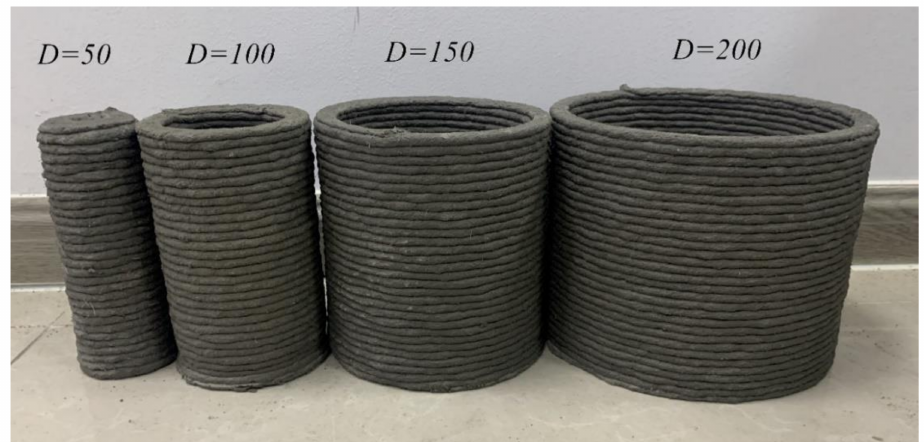
Figure 13. The four cylinders printed with the same BI of around 50. Table 5. Data and calculation of the printed cylinders with material mix OSS3. Unit D = 50 mm Printing speed